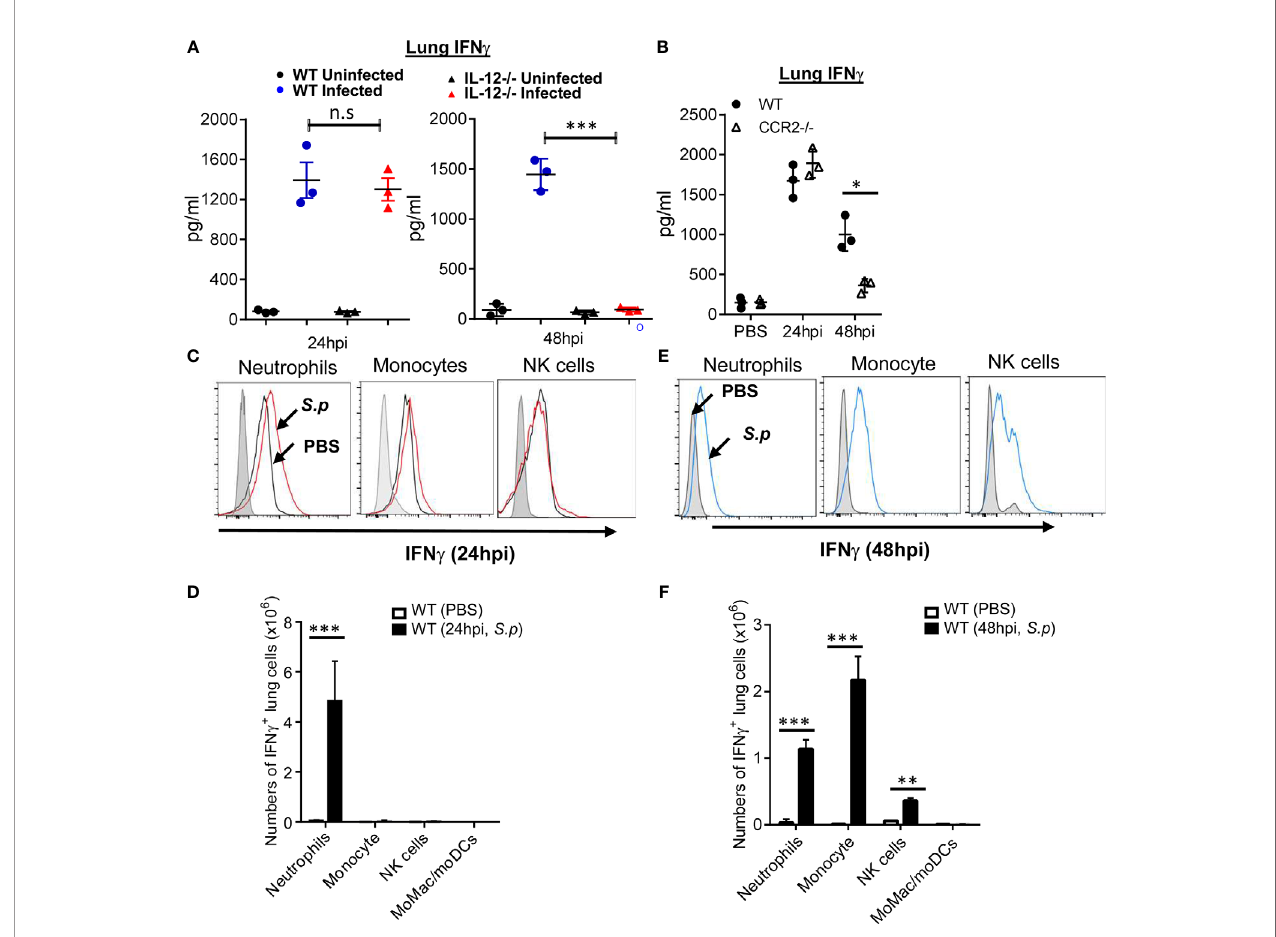
FIGURE 2 | Monocyte and IL-12p70 promote S. pneumoniae -induced late-stage lung IFN g production. (A) IL-12p70 − / − and WT littermates mice were infected (i.n.) with S. pneumoniae (D39 strain, ~5 × 10 6 CFU). IFN g in lung homogenates were measured at 24 and 48 hpi by ELISA (n = 3 mice per group). Data are representative of two independent experiments. (B) CCR2 − / − and WT littermates mice were infected (i.n.) with S. pneumoniae as in (A) . IFN g in lung homogenates were measured at 24 and 48 hpi by ELISA (n = 3 – 4 mice per group). Data are representative of three independent experiments. (C, E) Flow cytometry analysis of YFP expression (IFN g ) in lung immune cells from PBS or S. p (~5 × 10 6 CFU) infected IFN g reporter mice at 24 hpi (C) and 48 hpi (E) (n = 3 – 4 mice per group). Data are representative of three independent experiments. (D, F) Total cell numbers of IFN g + lung immune cells in (C, E) were enumerated. Graphs represent the mean with error bars indicating SEM. p -values determined by one-way ANOVA Tukey ’ s multiple comparison test. Signi fi cance is represented by asterisk, where * p < 0.05, ** p < 0.001, *** p < 0.0001, n.s., not signi fi